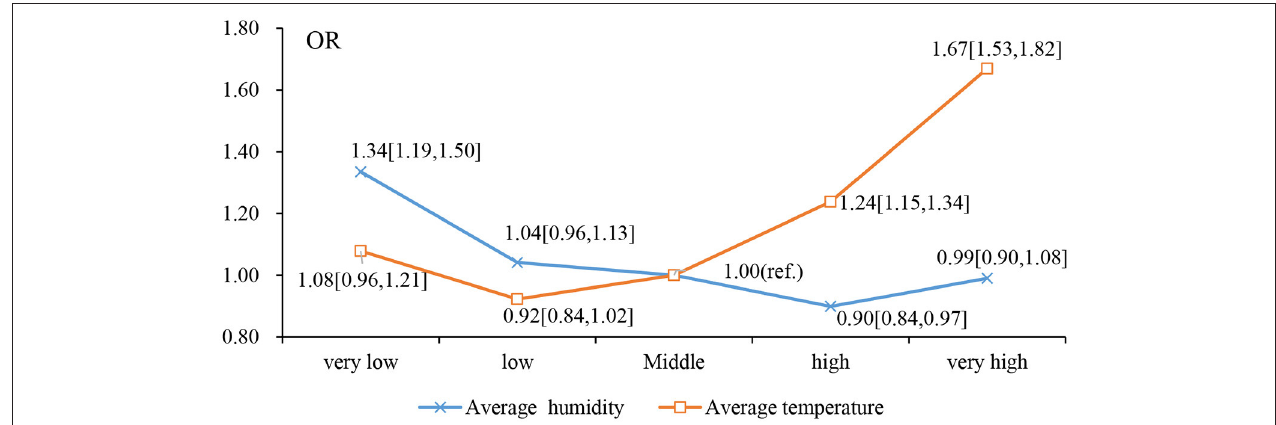
FIGURE 2 | Effects of Categorical air relative humidity and temperature on Cataracts: Odds Ratios (OR) from Model I in Table 4 .